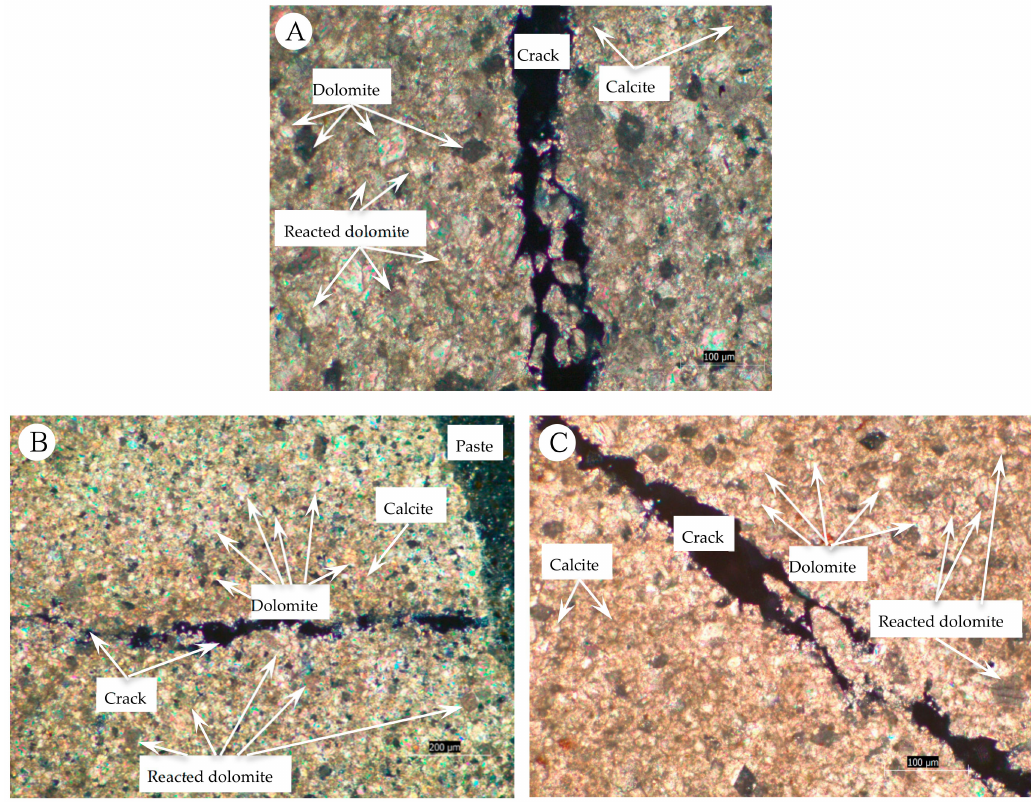
Figure 9. Thin section of concrete microbars prepared with dolomitic aggregate: ( A ) BFL1, NaOH 80 ◦ C 196 days; ( B ) BFL8, NaOH 80 ◦ C 196 days; ( C ) BFL1, TMAH 80 ◦ C 196